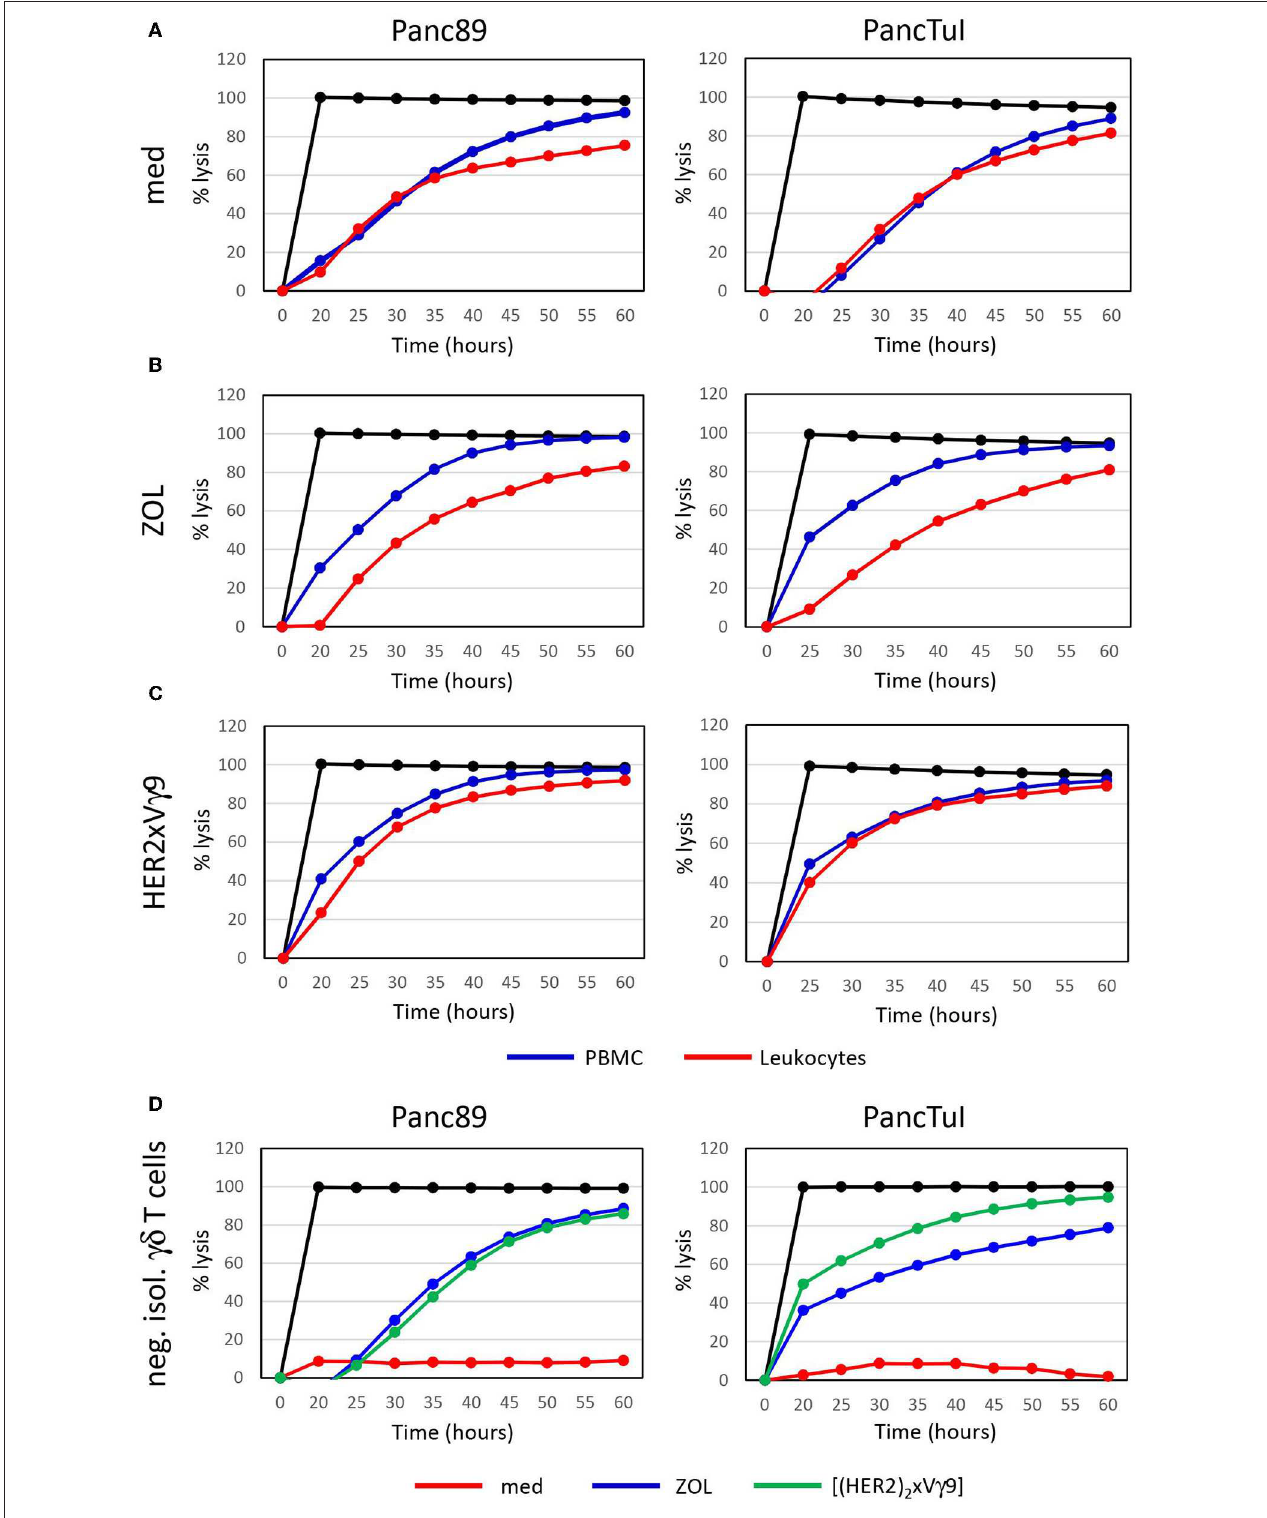
FIGURE 1 | Zoledronic acid-stimulated leukocytes diminish γδ T cell-cytotoxicity against PDAC cells. (A–C) Cytotoxicity of 250 × 10 3 PBMC (blue line) or 500 × 10 3 leukocytes (red line), which each comprised ∼ 7,500 γδ T cells or (D) 125,000 negatively isolated, resting γδ T cells (neg. isol. γδ T cells) in co-cultures with